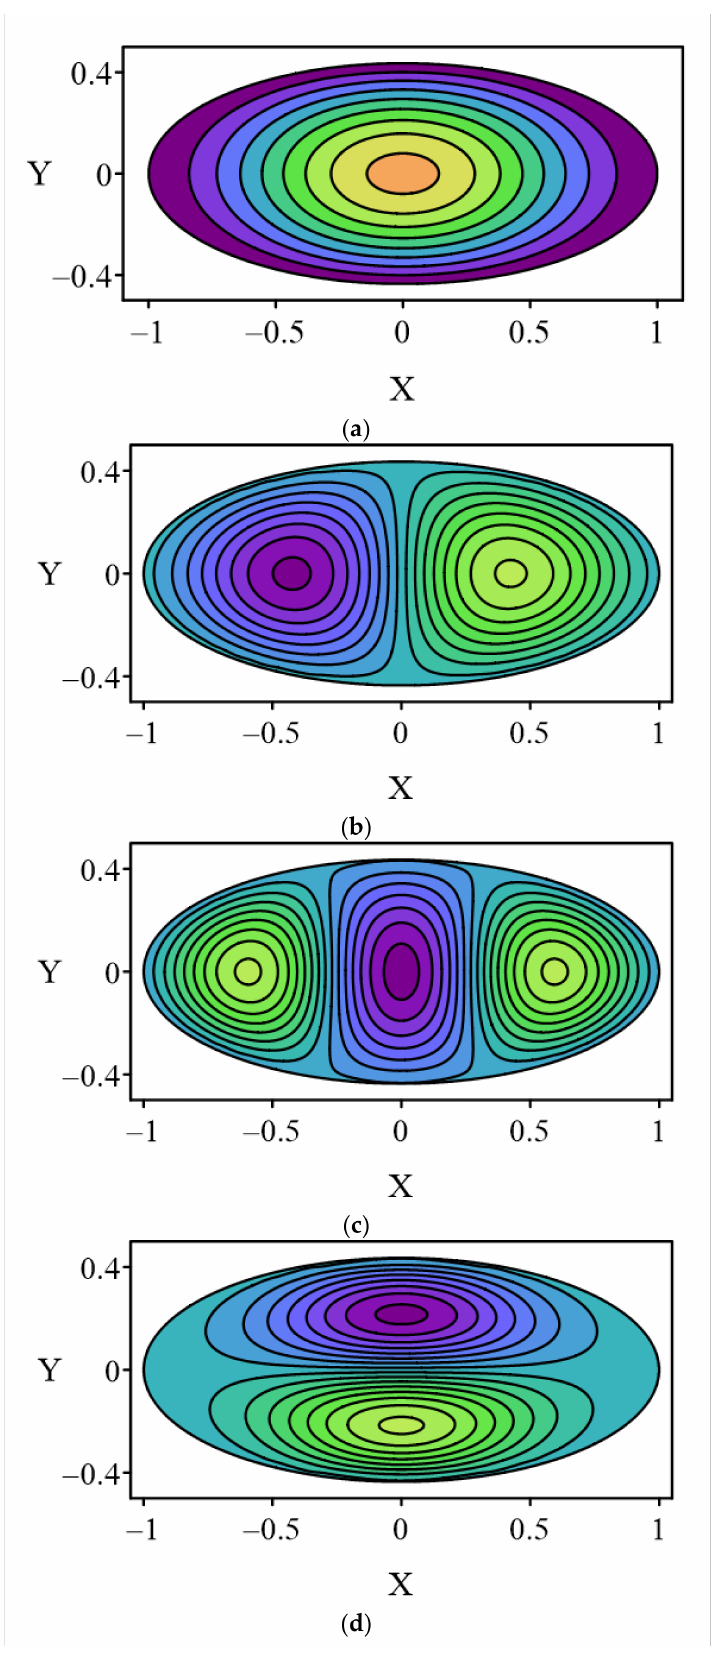
Figure 4. The first four eigenmodes for elliptic waveguide (TM wave): ( a ) k 1 = 4.2151, ( b ) k 2 = 5.4133, ( c ) k 3 = 6.7081, and ( d ) k 4 =